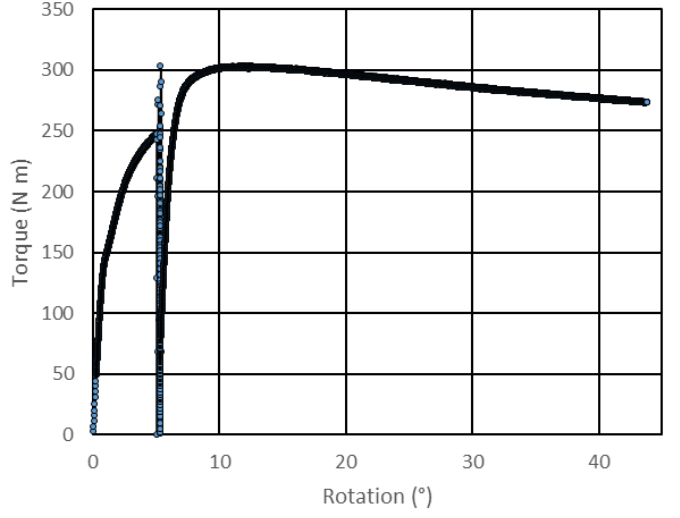
Figure 5. Torque-rotation curve obtained for the Loctite A 638 adhesive with a contact pressure of 1000 MPa.